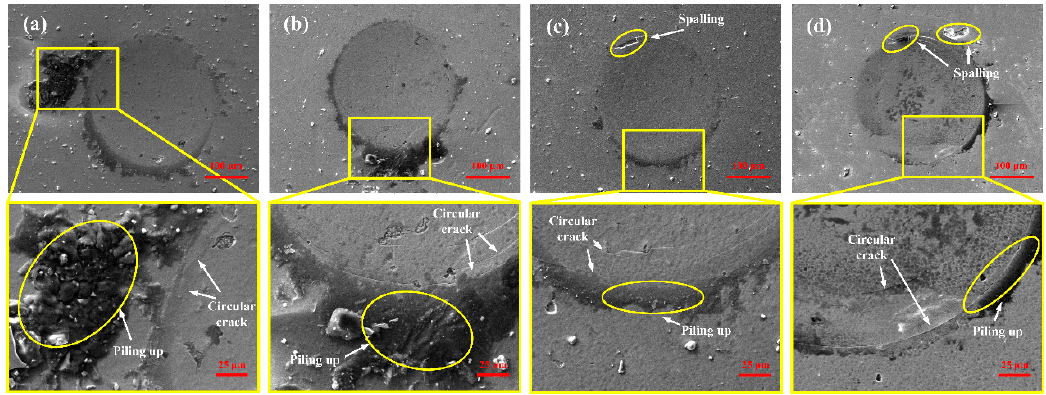
Figure 4. SEM micrographs of impact morphologies on the TiN coatings under different substrate temperatures: ( a ) Ts35; ( b ) Ts200; ( c ) Ts400; ( d ) Ts600.